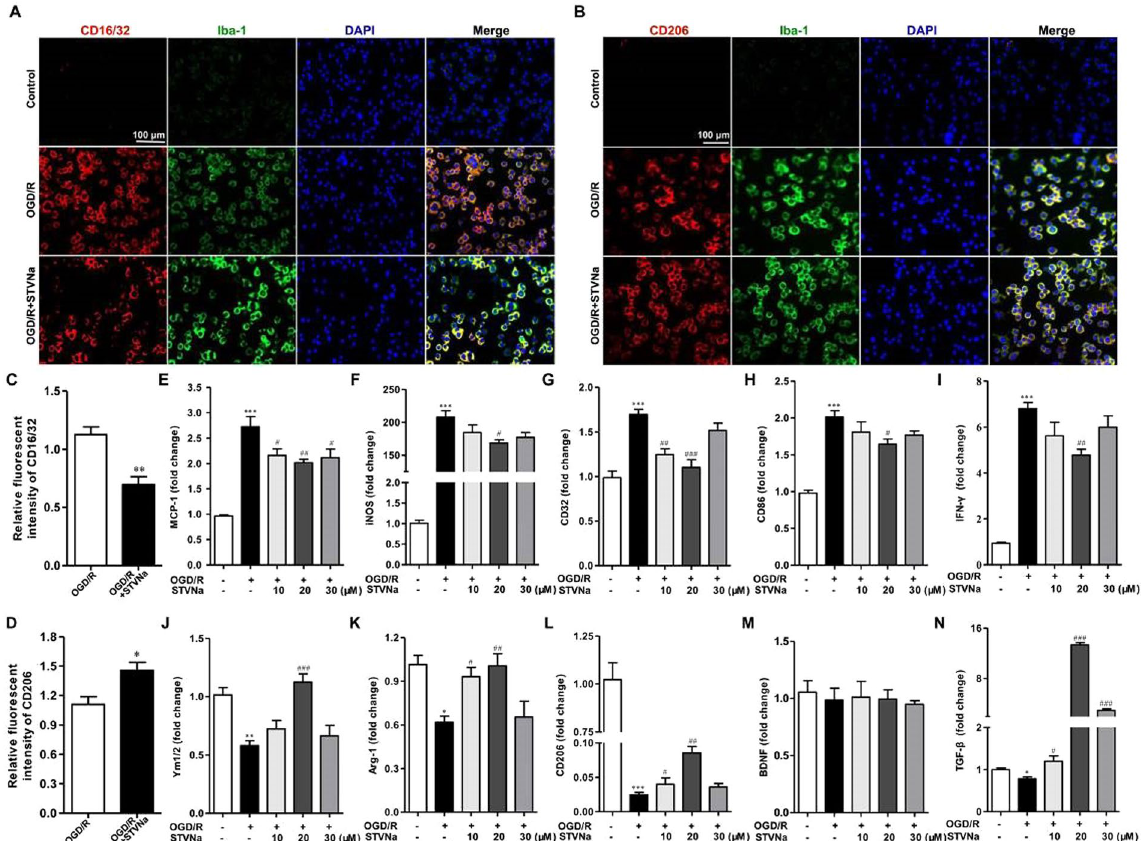
Figure 3. STV-Na inhibits M1 polarization and promotes M2 polarization in BV2 microglial cells after OGD/R. Representative double-immunofluorescence staining for CD16/32 or CD206 and Iba-1 markers in BV2 microglial cells obtained from STV-Na or vehicle treatment after OGD/R, or from Normal. Scale bar: 100 μ m. ( A ) BV2 microglial cells co-stained for CD16/32 (M1 marker) (red) and Iba-1(green). ( B ) BV2 microglial cells co-stained for CD206 (M2 marker) (red) and Iba-1 (green). ( C ) Quantification of the percentage of CD16/32 + / Iba-1 + cells among total Iba-1 + cells. ( D ) Quantification of the percentage of CD206 + /Iba-1 + cell among total Iba-1 + cells. ( E , F , G , H , I , J , K , L , M , N ) RT-PCR analysis of M1 (MCP-1, iNOS, CD32, CD86, IFN- γ ) and M2 (Ym1/2, Arg-1, CD206, BDNF, TGF- β ) markers in BV2 microglial cells after OGD/R. Data are represented as mean ± SD, * P < 0.05, ** P < 0.01, *** P < 0.01, versus control; # P < 0.05, ## P < 0.01, versus OGD/R